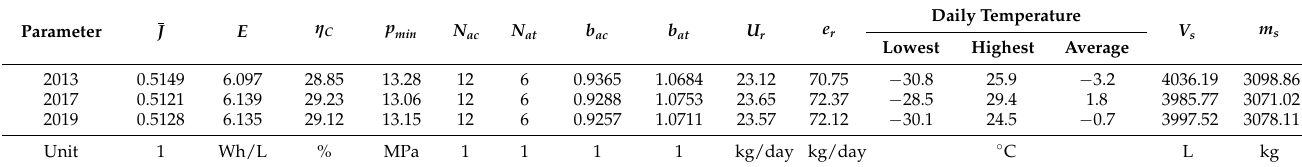
Table 5. Solution results of AMGO in different